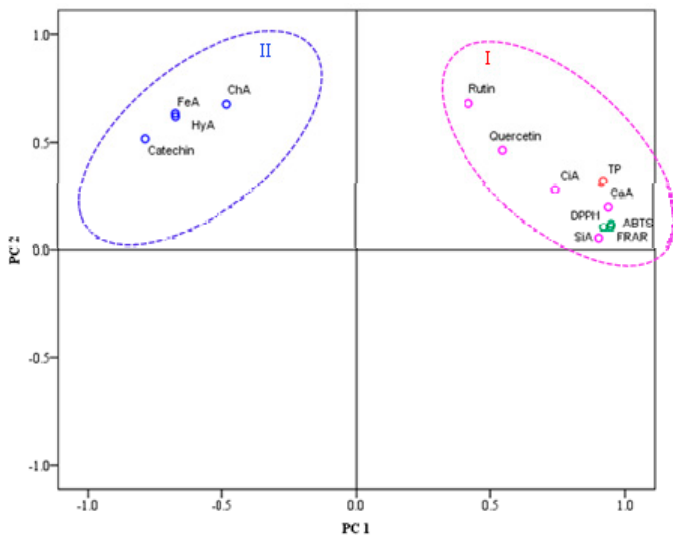
Figure 7. Principal component analysis (PCA) of individual phenols, total phenols, and antioxidant activity of broccoli. Groups Ⅰ and Ⅱ represent the first principal component (PC1) and second principal component (PC2), respectively. CiA represents cinnamic acid. CaA represents caffeic acid. SiA represents sinapic acid. ChA represents chlorogenic acid. FeA represents ferulic acid. HyA represents hydroxybenzoic acid.